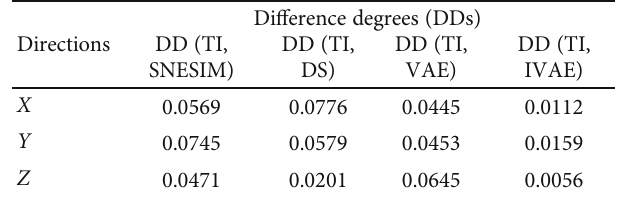
Table 3: Di ff erence degrees ( DD s) between the TI and the reconstructions of IVAE, SNESIM, VAE and DS measured by variogram di ff erences in the X , Y , and Z